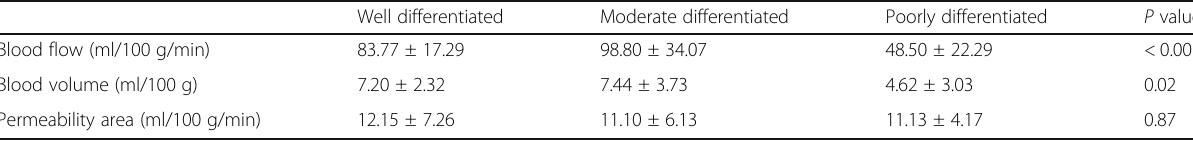
Table 2 Correlation of the CT Perfusion parameters to the grade of colorectal cancer at the tumor center using 30 mm 2 ROI Well differentiated Moderate differentiated Poorly